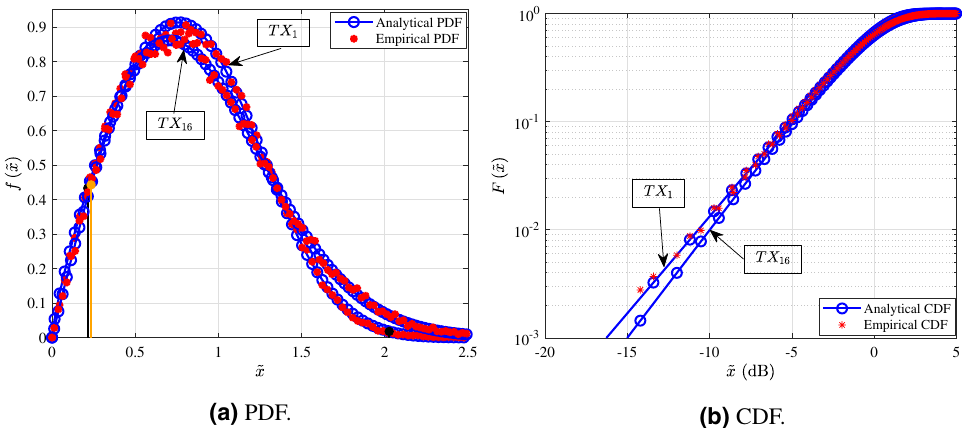
Figure 5. Fitting of PDF and CDF analytical expressions to the empirical channel gain data of some indicative links (1 and 16) for the airport check in area.